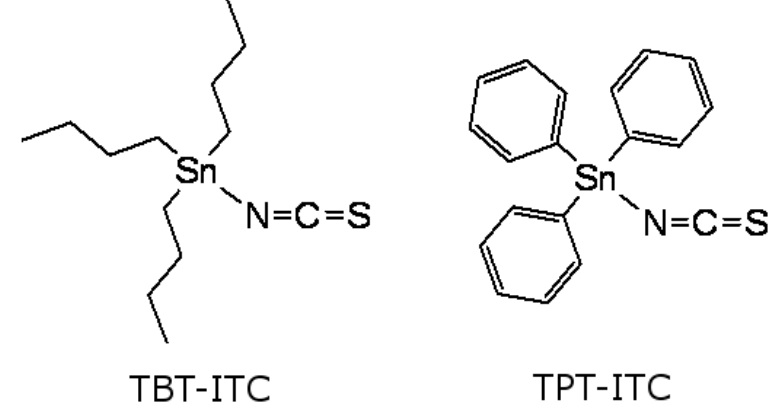
Figure 1. Structures of tributyltin isothiocyanate (TBT-ITC) and triphenyltin isothiocyanate